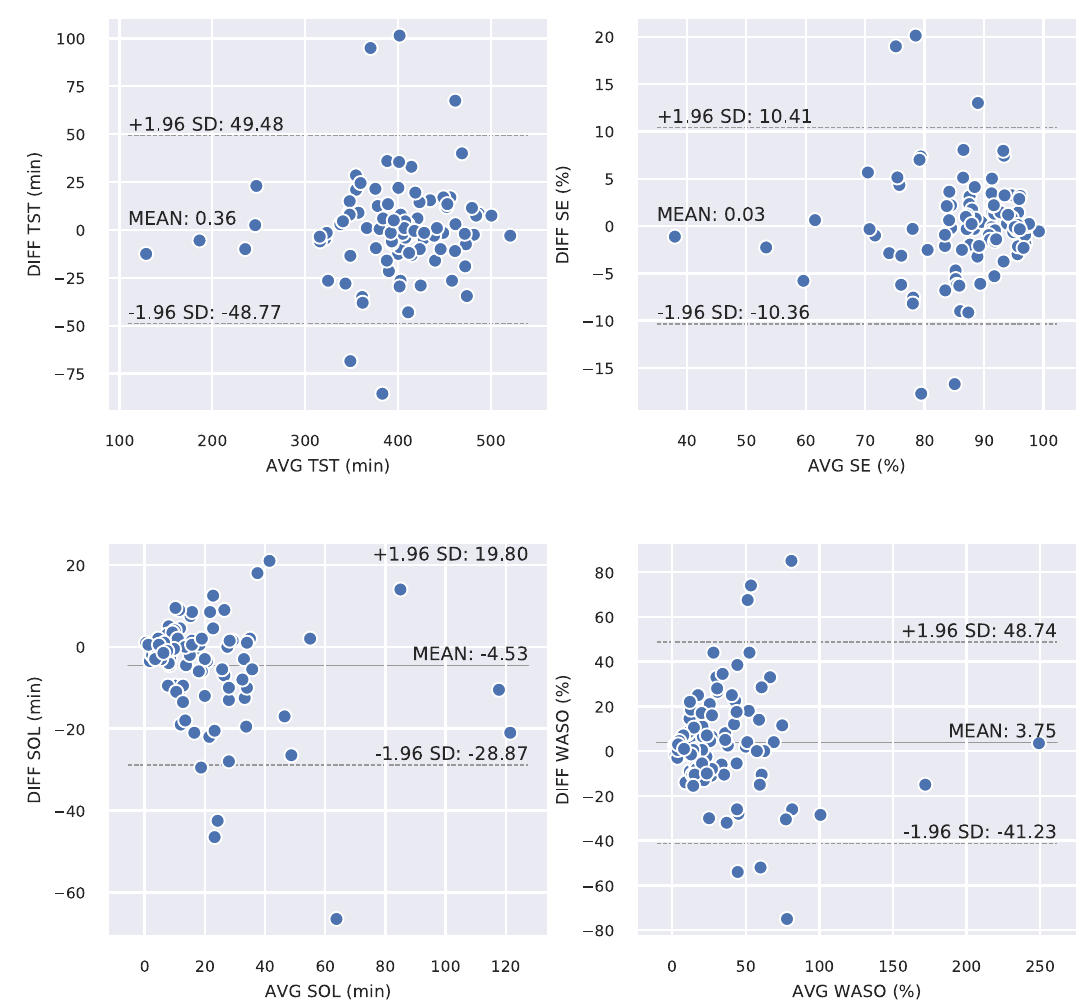
Fig. 6 Bland-Altman analysis of the four main sleep-wake statistics, between reference and the combined retrain transfer learning approach. AVG on the horizontal axis is the mean between true and predicted values and DIFF on the vertical axis is the error (predicted value – true